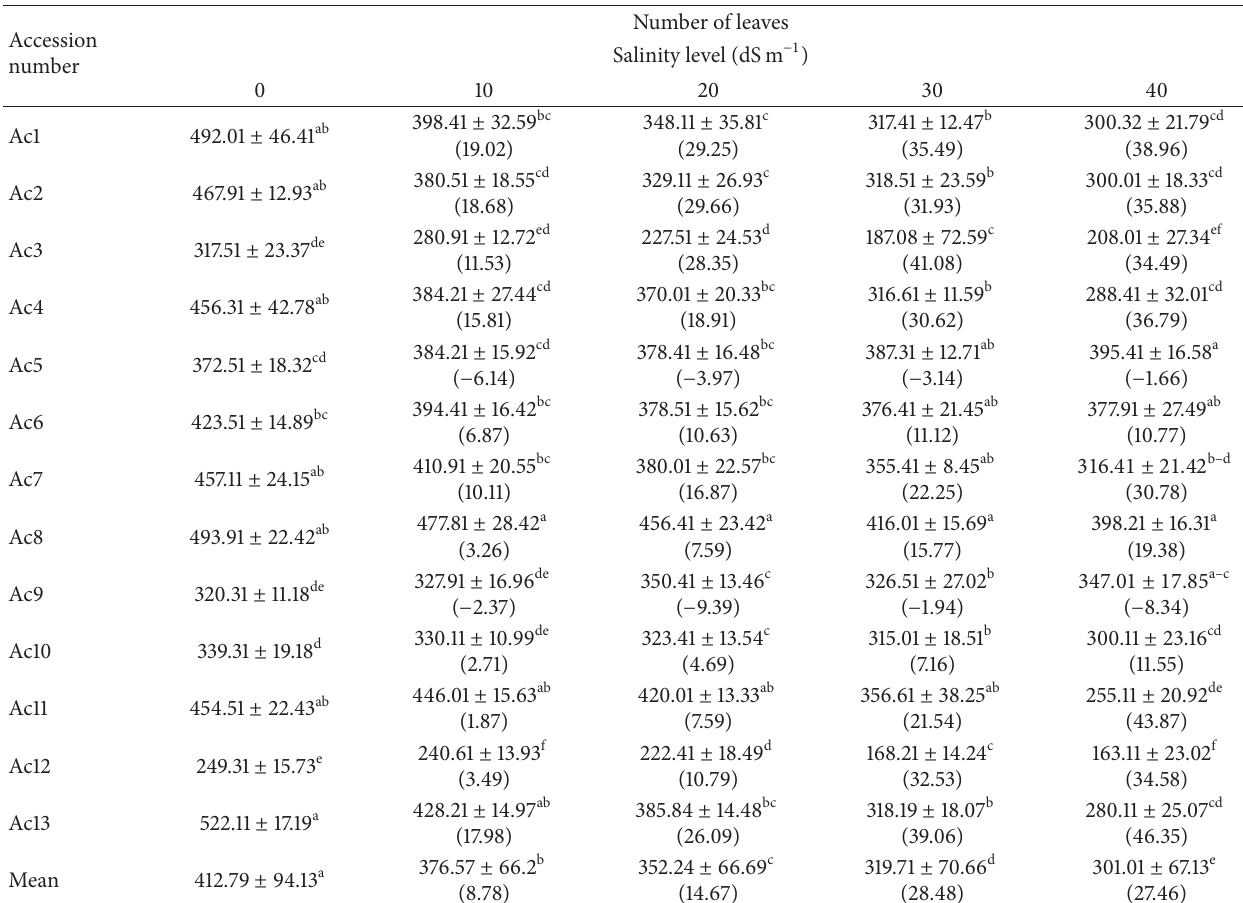
Table 6: Effect of salinity on number of leaves of 13 salt treated purslane